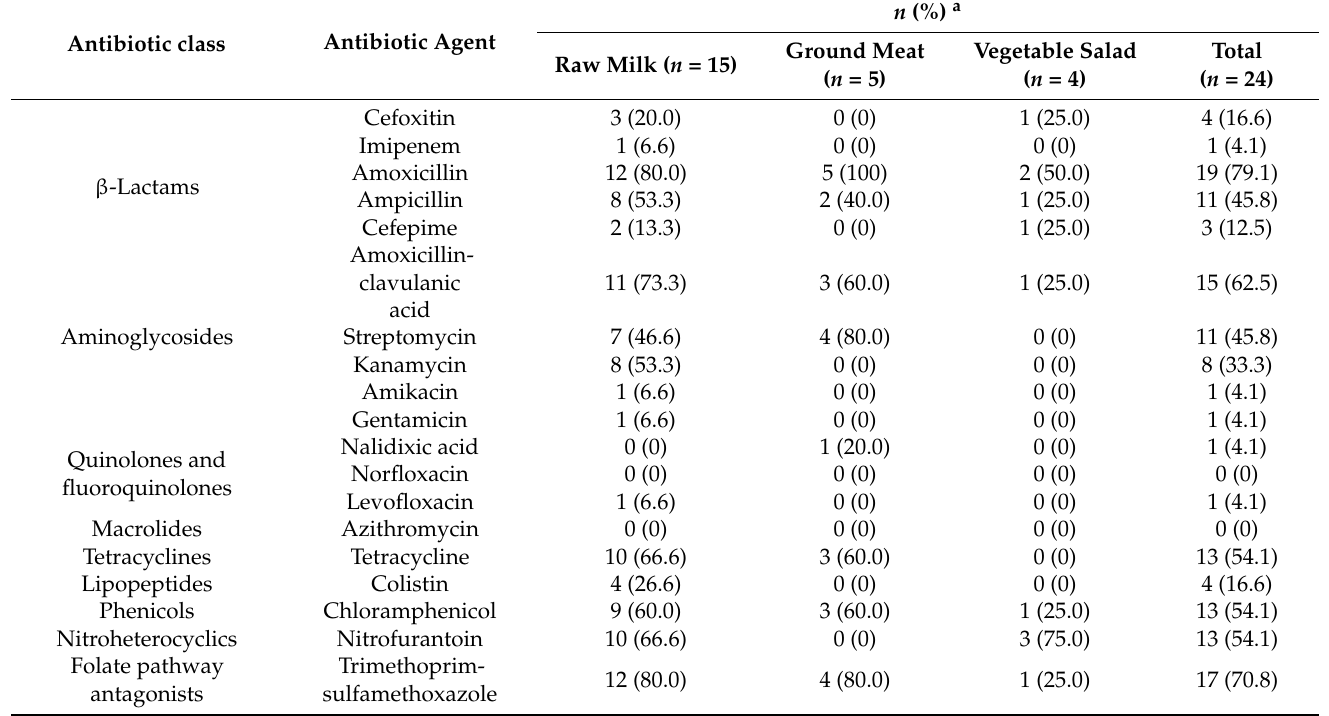
Table 1. Antibiotic resistance phenotype of E. coli isolated from food samples.